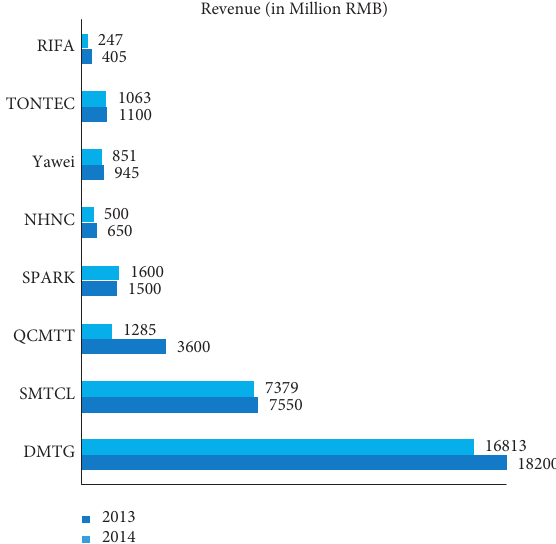
Figure 1: Revenue of Chinese machine tool enterprises from 2013 to